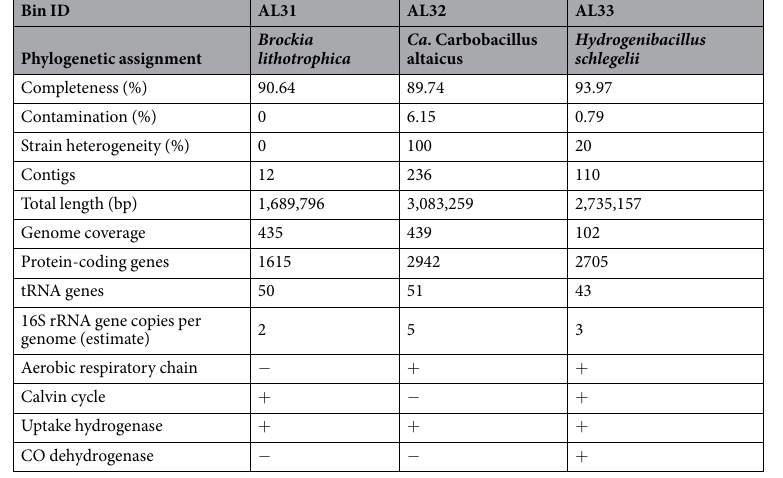
Table 2. General characteristics of genomes obtained in this